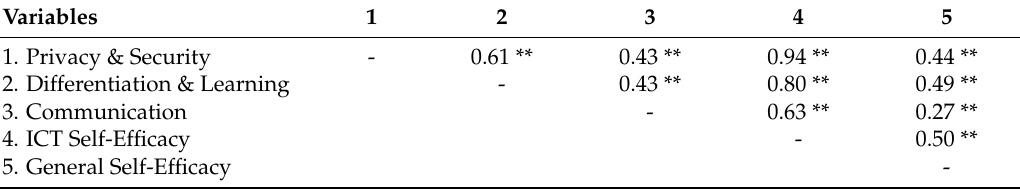
Table 2. Pearson bivariate correlations between ICT Self-Efficacy and General Self-Efficacy.